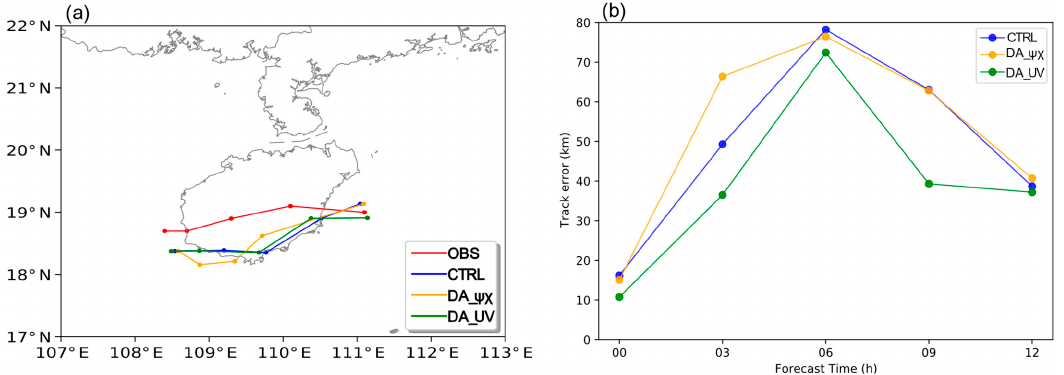
Figure 11. ( a ) The best track from CMA and others from three experiments during forecast time; ( b ) the track errors to the best track of three experiments during forecast time.